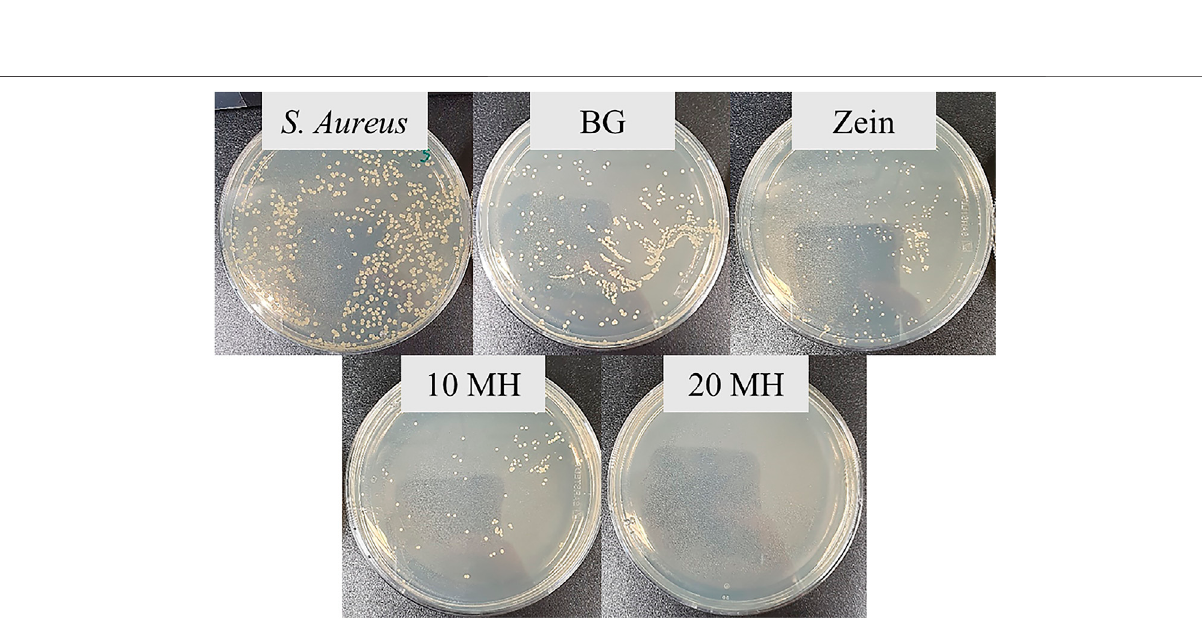
Frontiers in Materials |